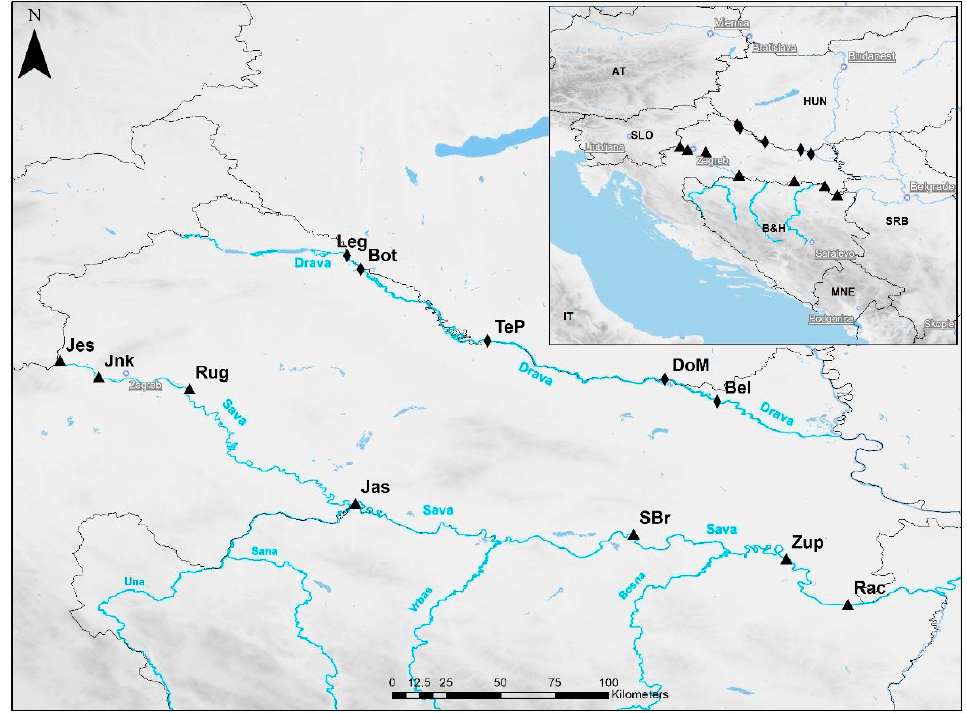
Figure 1. A map of Croatia with the collection sites of water samples for analysis of PhACs.